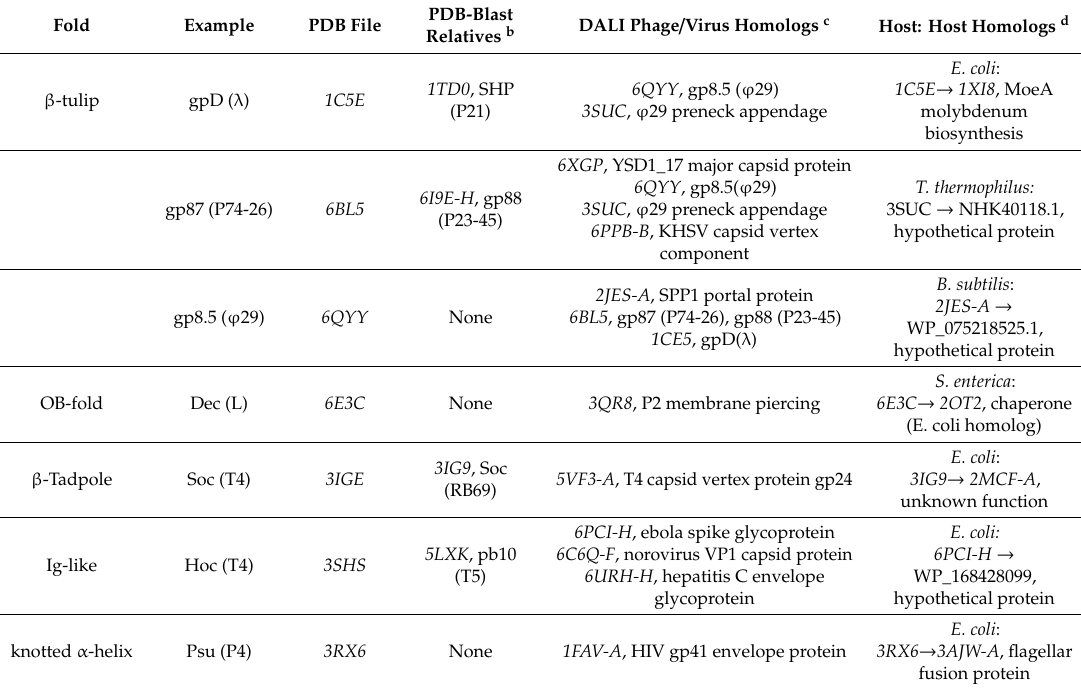
Table 2. Decoration Protein Structural Homology a